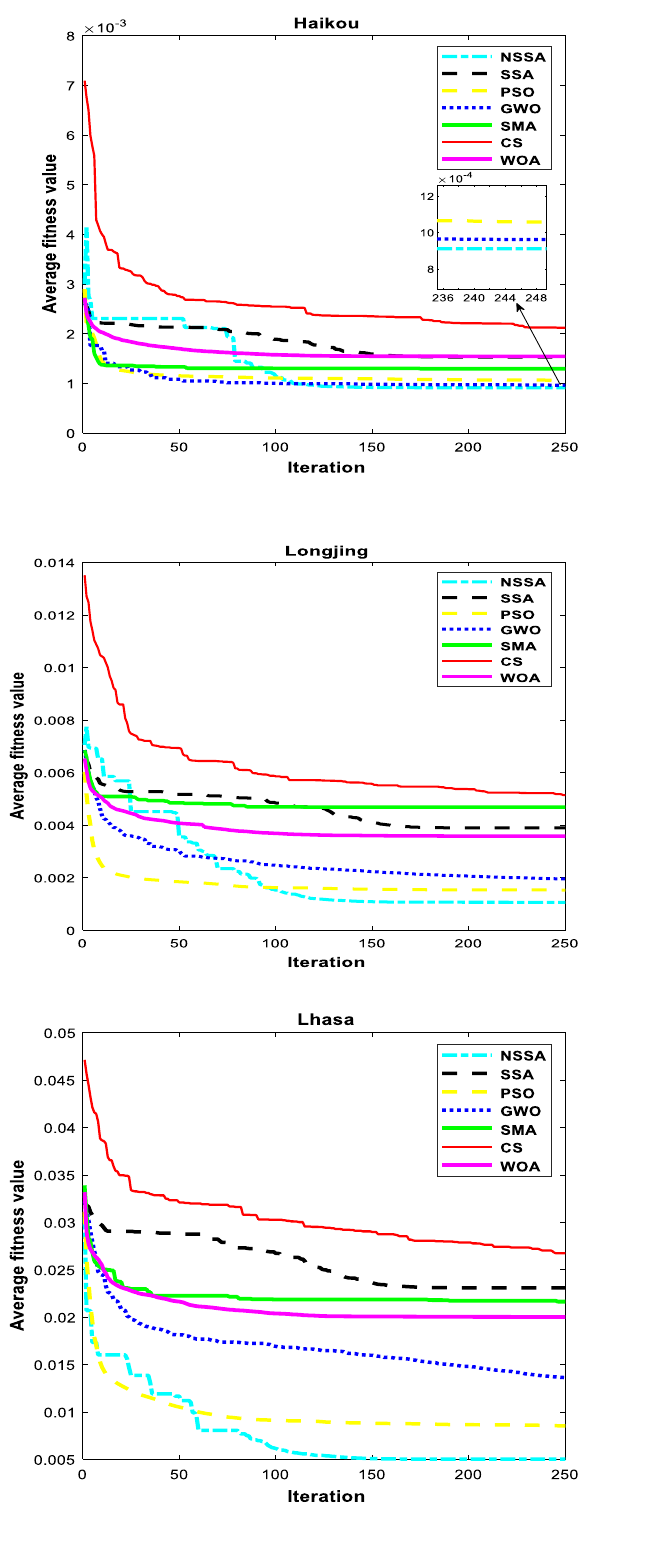
Fig. 8 Average iterative curve of predicted Tdew during